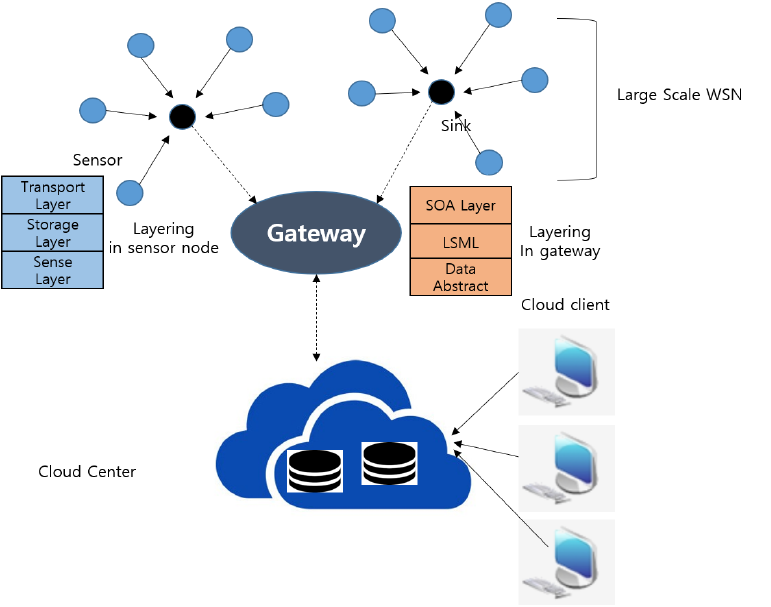
Figure 5. Architecture of